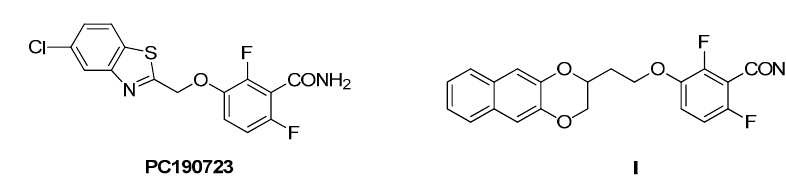
Figure 1. Structures of PC190723 , derivatives I and II.